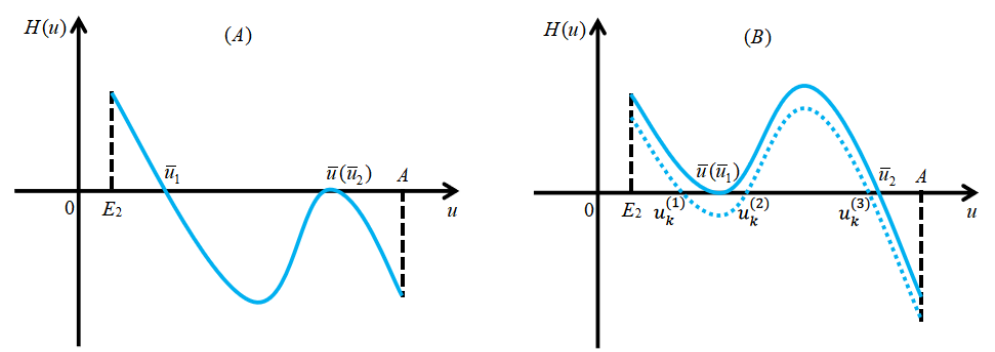
Figure 4. Panel ( A ) indicates the case that equation h ( u ) − ku = 0 has two positive real roots; panel (B) shows that the equation may have exactly three positive real roots by small perturbation based on the solid curve in panel ( B